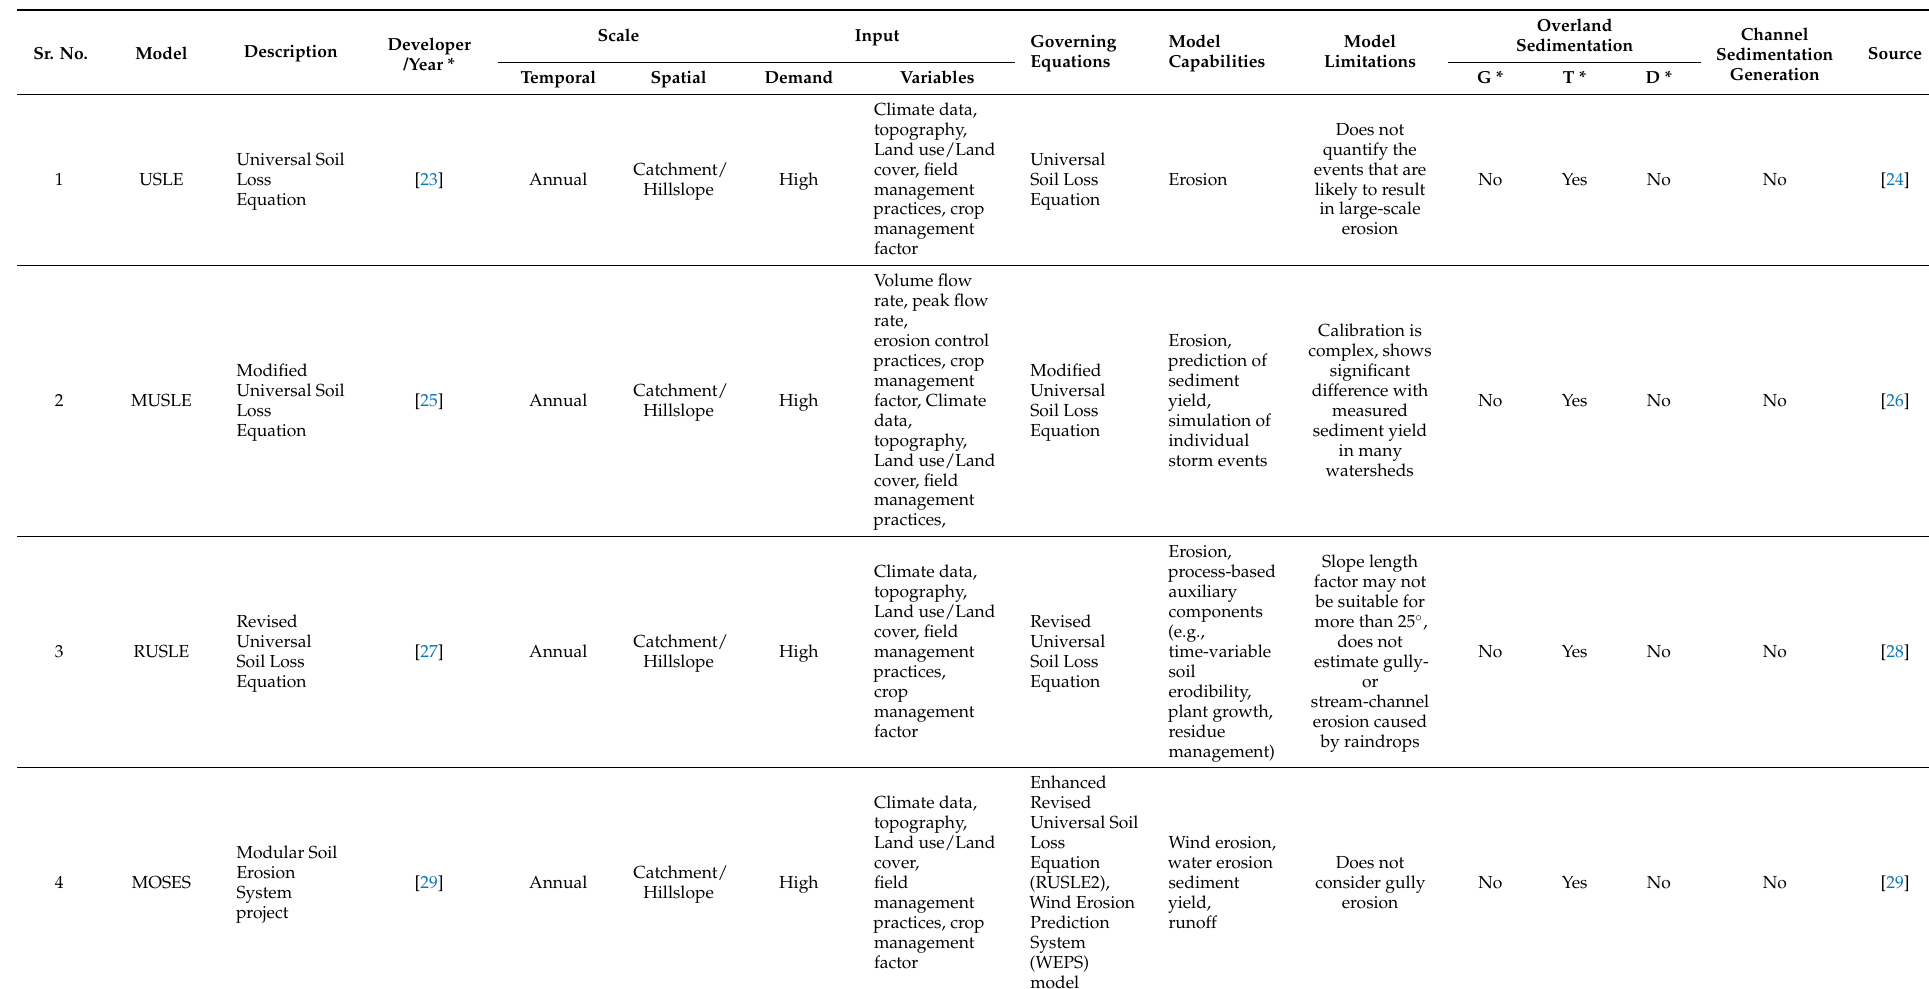
Table 3. Empirical soil erosion